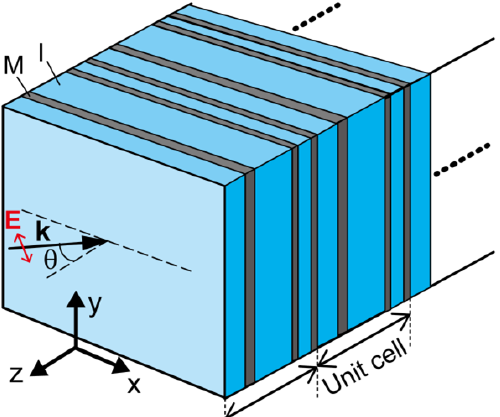
Figure 1. Schematic of stratified metal-insulator metamaterials (SMIMs) of a complex unit cell. As an example, a SMIM of a six-layer unit cell is illustrated. Gray denotes metal (M) and pale blue insulator (I). The optical configuration of incidence is also shown with the wavevector k , the E-field vector E and the angle θ